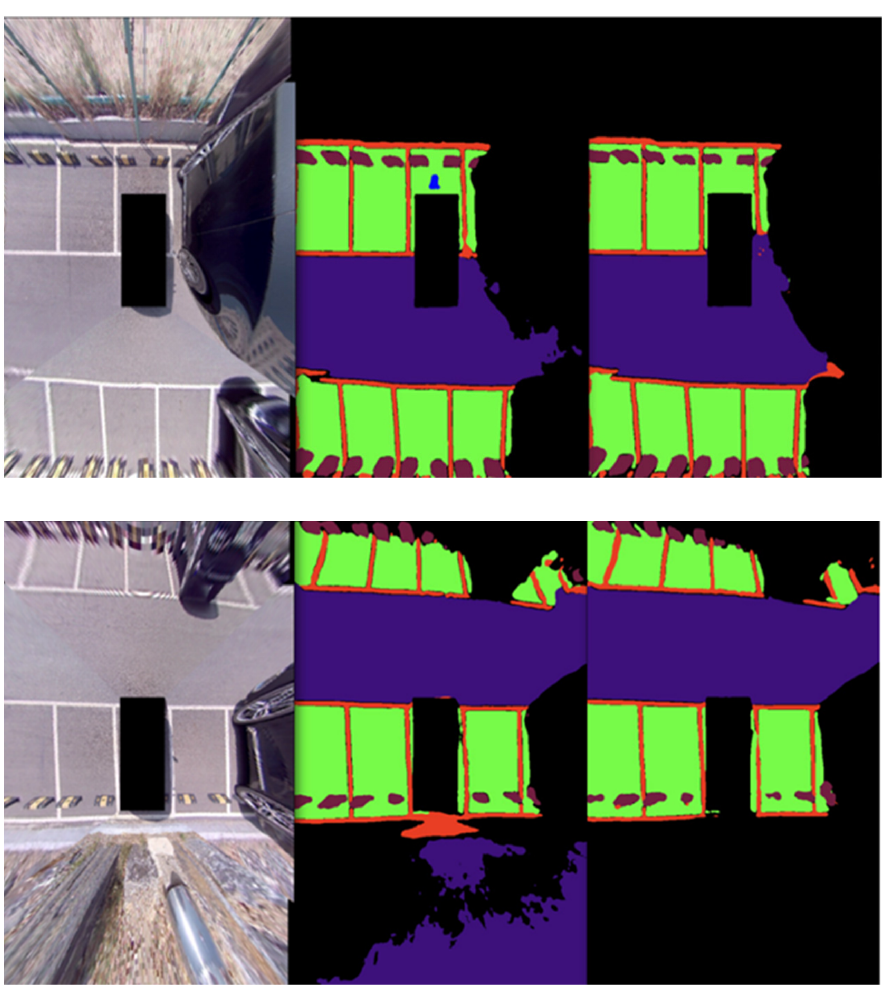
Figure 12. Performance comparison of a ttention . Left: input; middle: CSPHarDNet; right: attention.